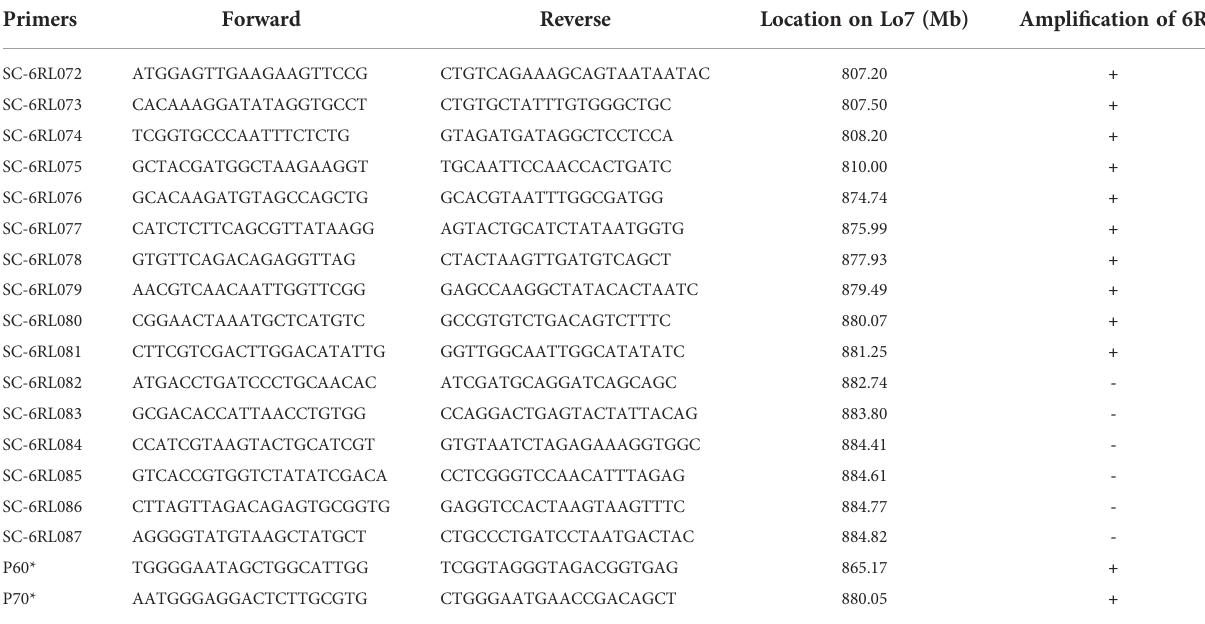
TABLE 2 The 6RL-speci fi c markers used on